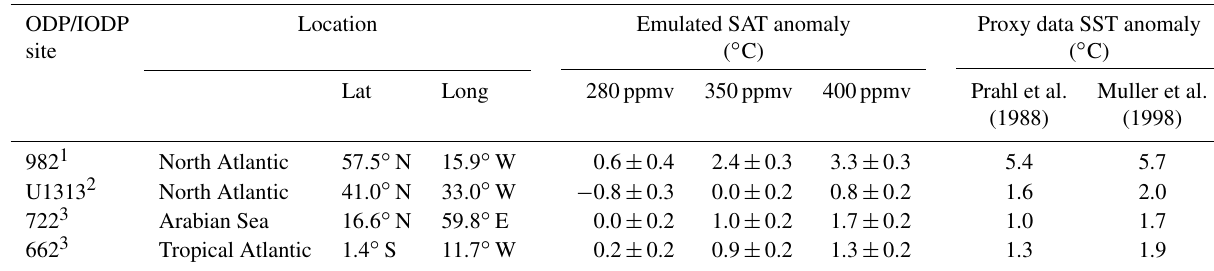
Table 4. Mean temperature anomalies and uncertainties (1SD – standard deviation) for the period 3300–2800kyrBP estimated by the emulator and alkenone proxy data for the four ODP/IODP